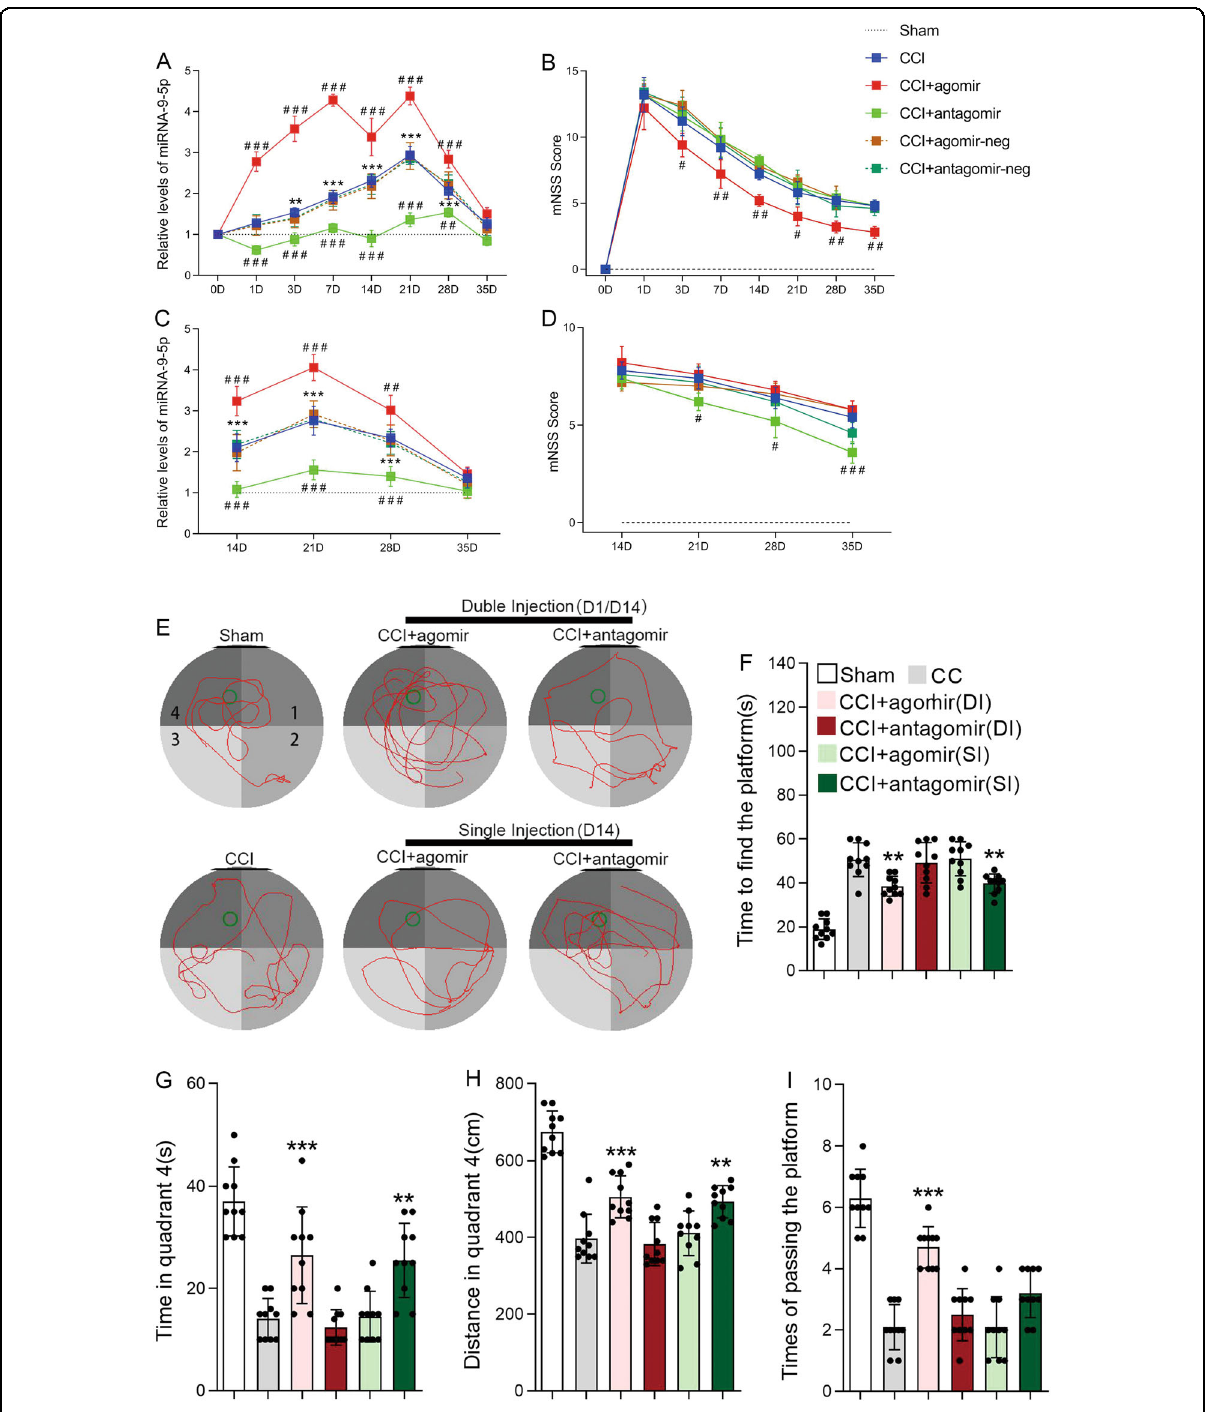
Fig. 1 Alteration of miRNA-9-5p affected neurological outcomes after CCI. A The temporal pro fi le of the miRNA-9-5p level in traumatic foci from 1 to 35 days was detected by qRT-PCR. B The neurological outcome after treatment with miRNA-9-5p oligomers from 1 to 35 days was evaluated by the mNSS. C The temporal pro fi le of the miRNA-9-5p level in traumatic foci from 14 to 35 days was detected by qRT-PCR. D The neurological outcome after treatment with miRNA-9-5p oligomers from 14 to 35 days was evaluated by the mNSS ( n = 5/group). (** P < 0.01, *** P < 0.001 versus the sham group; # P < 0.05, ## P < 0.01, ### P < 0.001 versus the CCI group.) E Spatial learning and memory were evaluated using the Morris water maze test. F The time to fi nding the platform. G The times to passing through the platform. H The distance traversed in quadrant 4. I The time spent in quadrant 4 ( n = 10/group) (* P < 0.05, ** P < 0.01, *** P < 0.001 versus the CCI group) (CCI: control cortex impact, DI: double injection, SI: single injection). Error bars indicate mean±